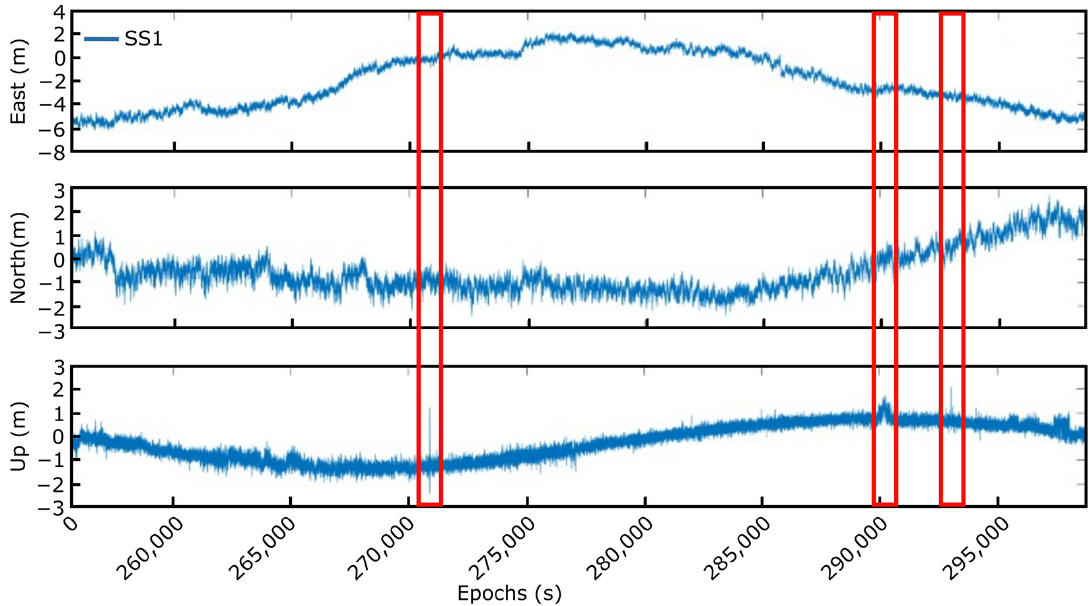
Figure 17. Twelve-hour measurement at the marking buoy.